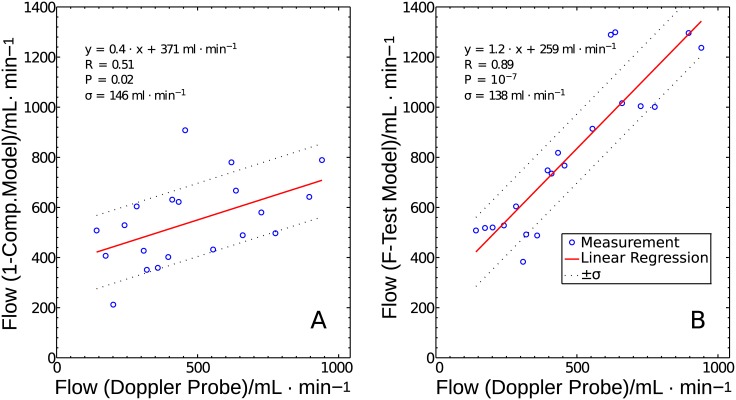
Regression of the corrected DCE-MRI models.Regression of the corrected DCE-MRI model results with the Doppler flow values for the one-compartment model (A) and for the F-test selection method (B). The solid line represents the linear regression fit of the measured data (circles). The dotted line depicts the standard deviation of the data related to the linear regression.